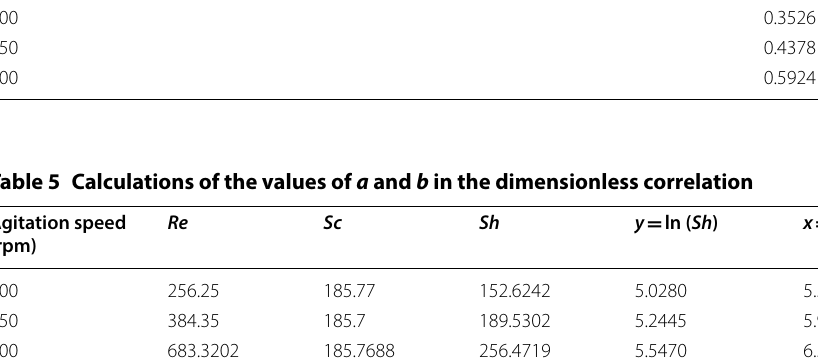
Table 4 Mass transfer coefficient as a function of agitation speed Agitation speed(rpm)